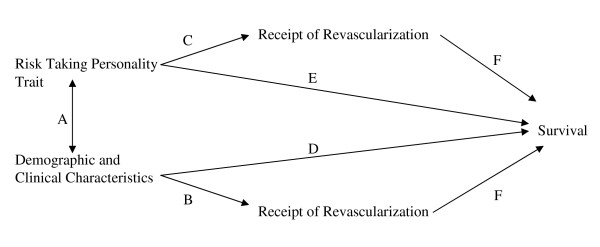
Conceptual Model to Guide Analysis.